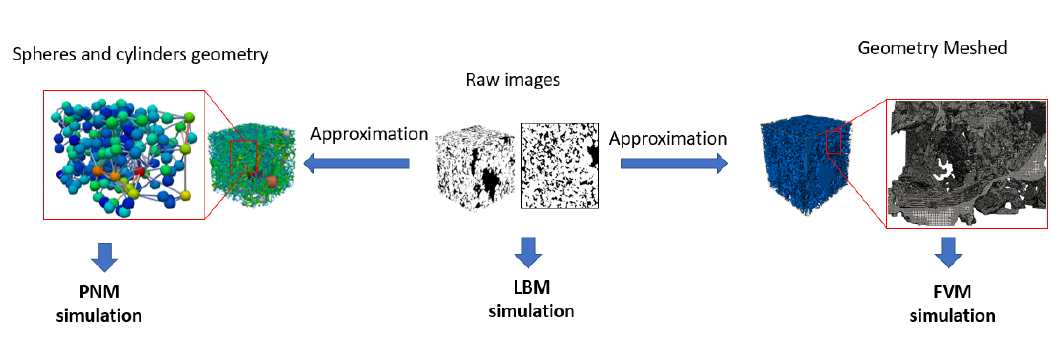
Figure 4. The input pore geometry for pore-network model (PNM), lattice Boltzmann method (LBM), and finite volume method (FVM) simulations based on the Grosmont carbonate micro-CT